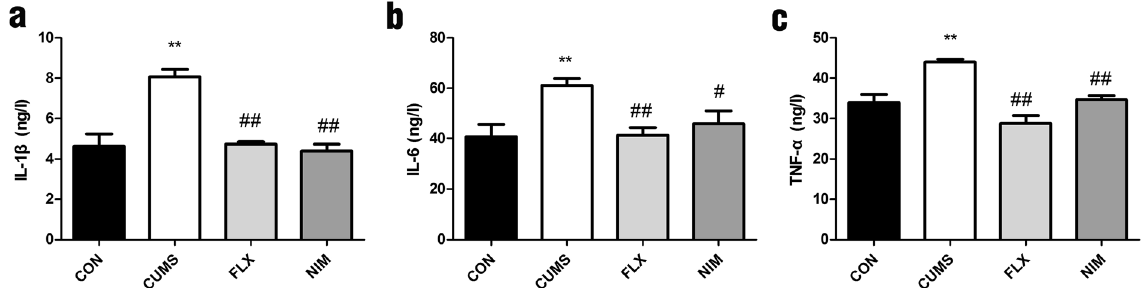
Figure 2. Effects of nimesulide on levels of cytokines in CUMS rats. ( a ) Nimesulide decreased the levels of IL-1 β in CUMS rats. ( b ) Nimesulide decreased the levels of IL-6 in CUMS rats. ( c ) Nimesulide decreased the levels of TNF- α in CUMS rats. All data are presented as mean ± SEM, n = 3 rats/group. ** p < 0.01 vs. CON; ## p < 0.01, # p < 0.05 vs. CUMS. One - way ANOVA followed by Dennett’s